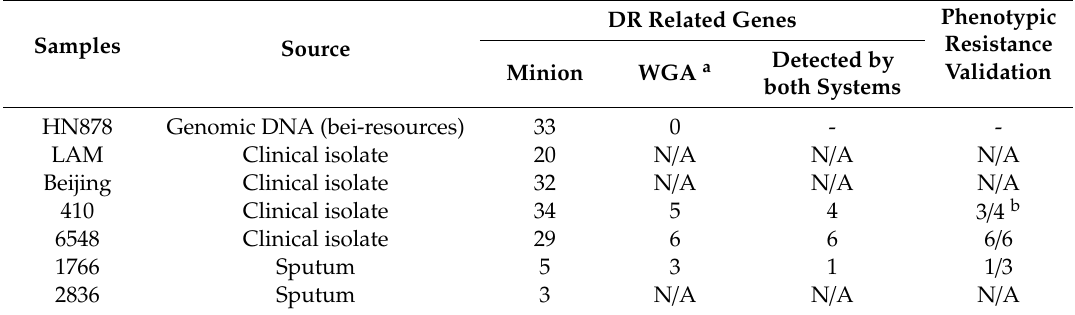
Table 2. Mutations observed in drug resistance (DR) related genes through MinION and previous whole genome analysis (WGA) sequencing